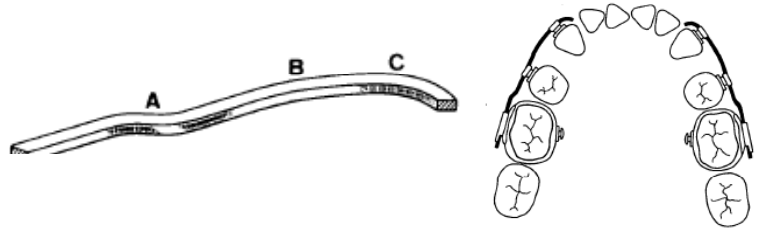
Figure 19: Sectional nickel-titanium archwire with elastomeric chain